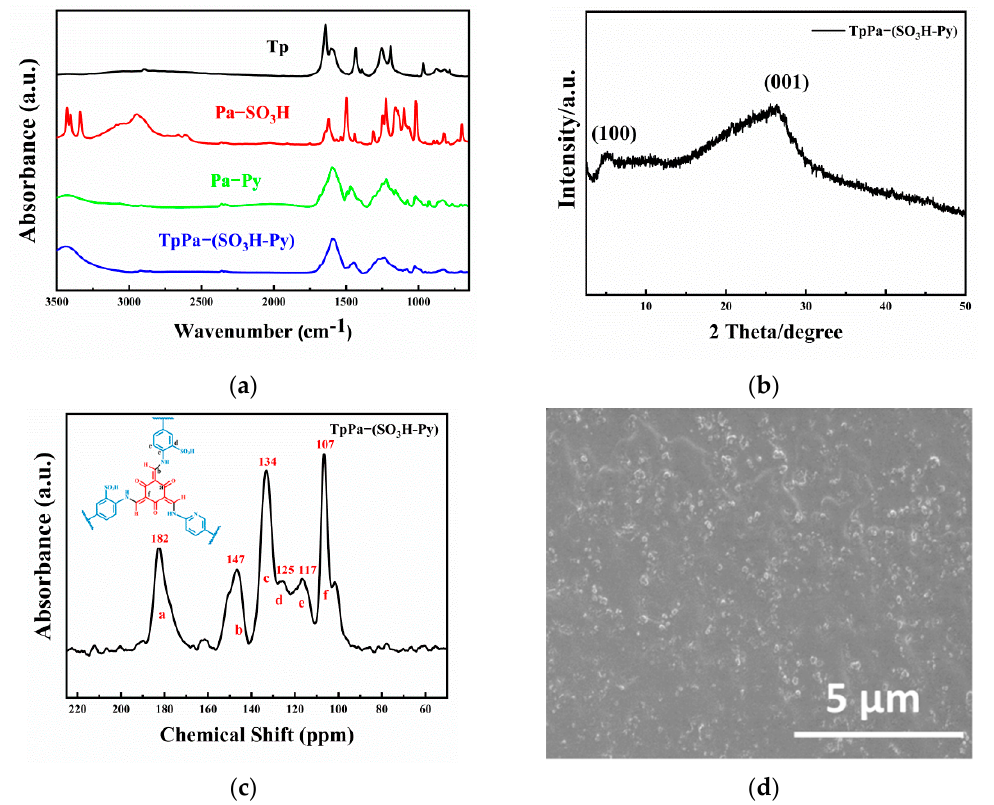
Figure 8. ( a ) FTIR, ( b ) XRD, ( c ) NMR spectra of TpPa − (SO 3 H-Py), ( d ) SEM cross-section images of SPEEK/TpPa − (SO 3 H-Py).